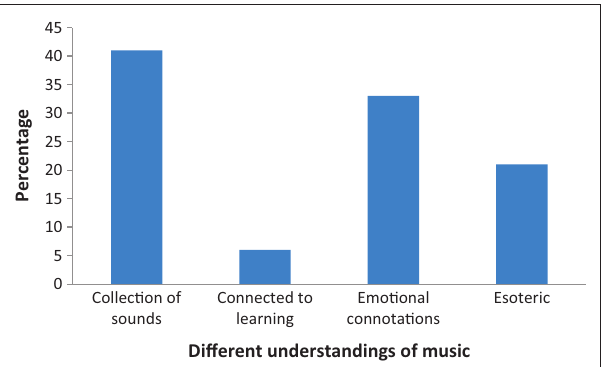
FIGURE 3: The 2013–2014 pre-course understandings of music.